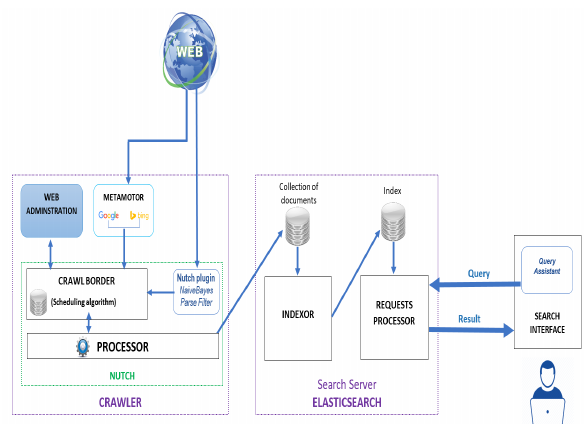
Figure 3 . Architecture of the dedicated search